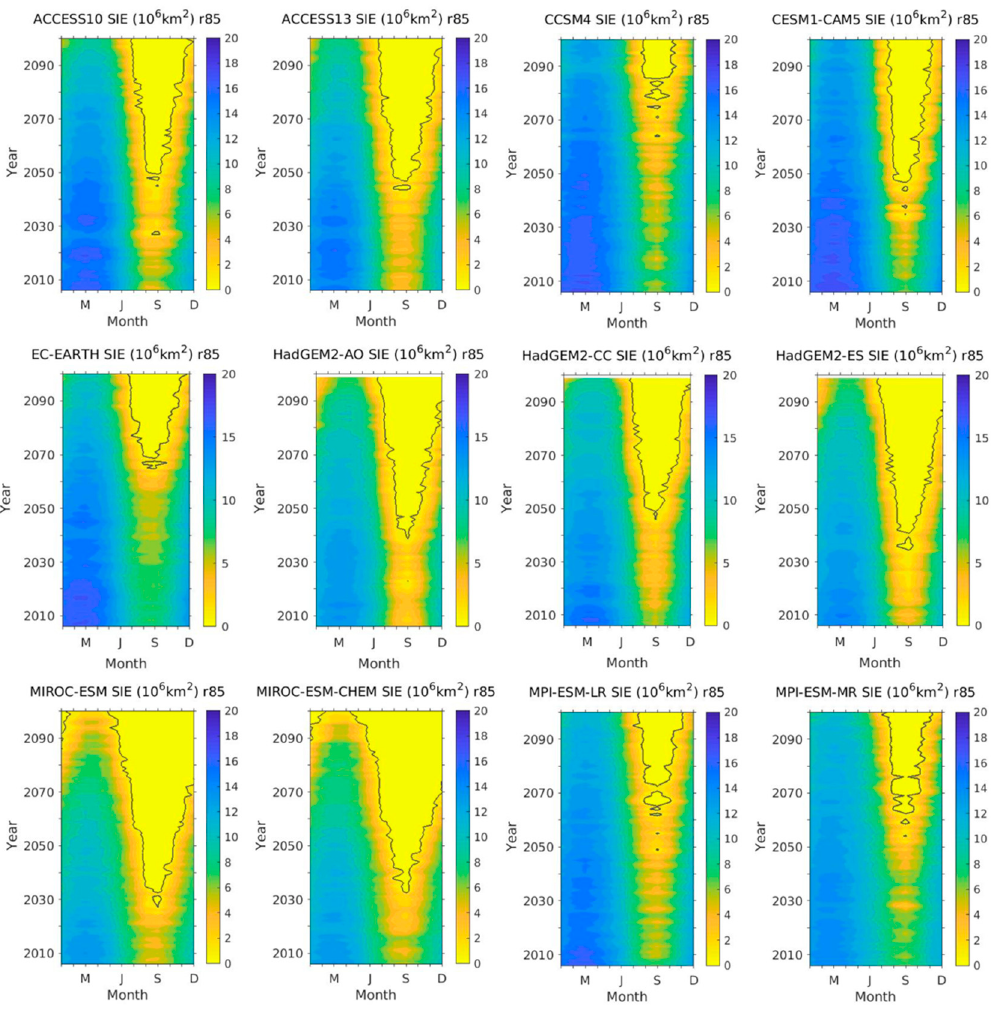
Figure 3. Same as Figure 2 except for the high emission scenario RCP8.5 (r85).